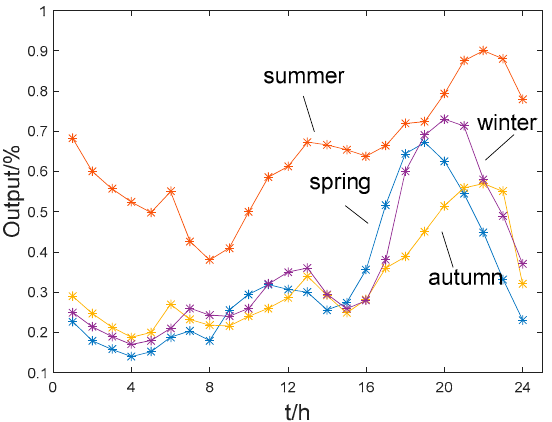
Figure 4. Residential loads timing characteristics curve.